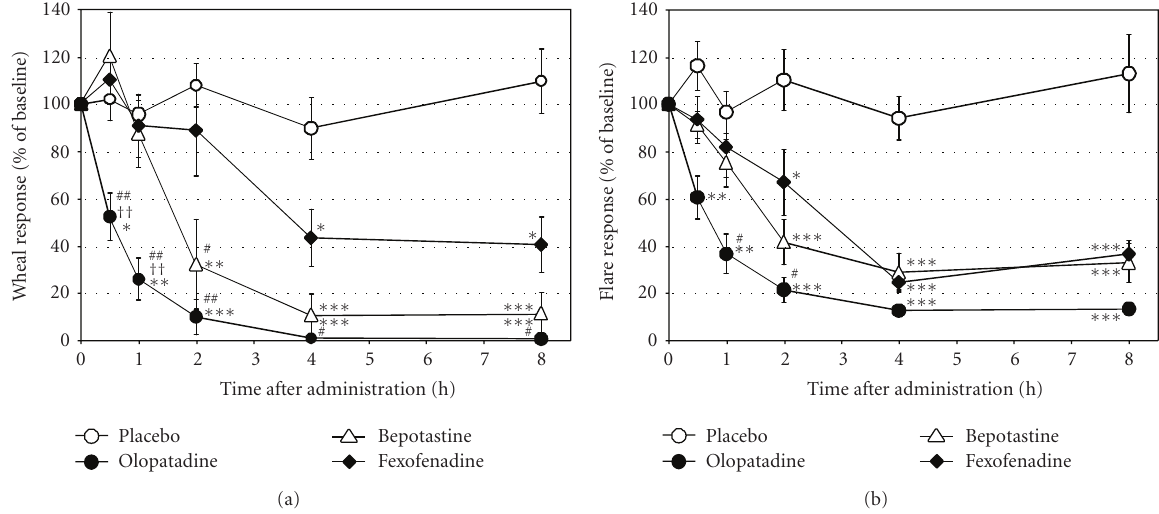
Figure 1: Inhibitory e ff ects of anti-histamines on histamine-induced wheal response (a) and flare response (b) after histamine iontophoresis treatment ( n = 10). Results are presented as mean ± SE. ∗ P < .05, ∗∗ P < .01, and ∗∗∗ P < .001 (olopatadine versus placebo); †† P < .01 (olopatadine versus bepotastine); # P < .05, ## P < 0.01 (olopatadine versus